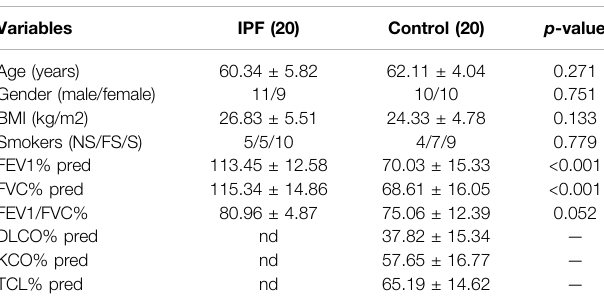
TABLE 2 | Clinicopathological variables of IPF and Controls in this